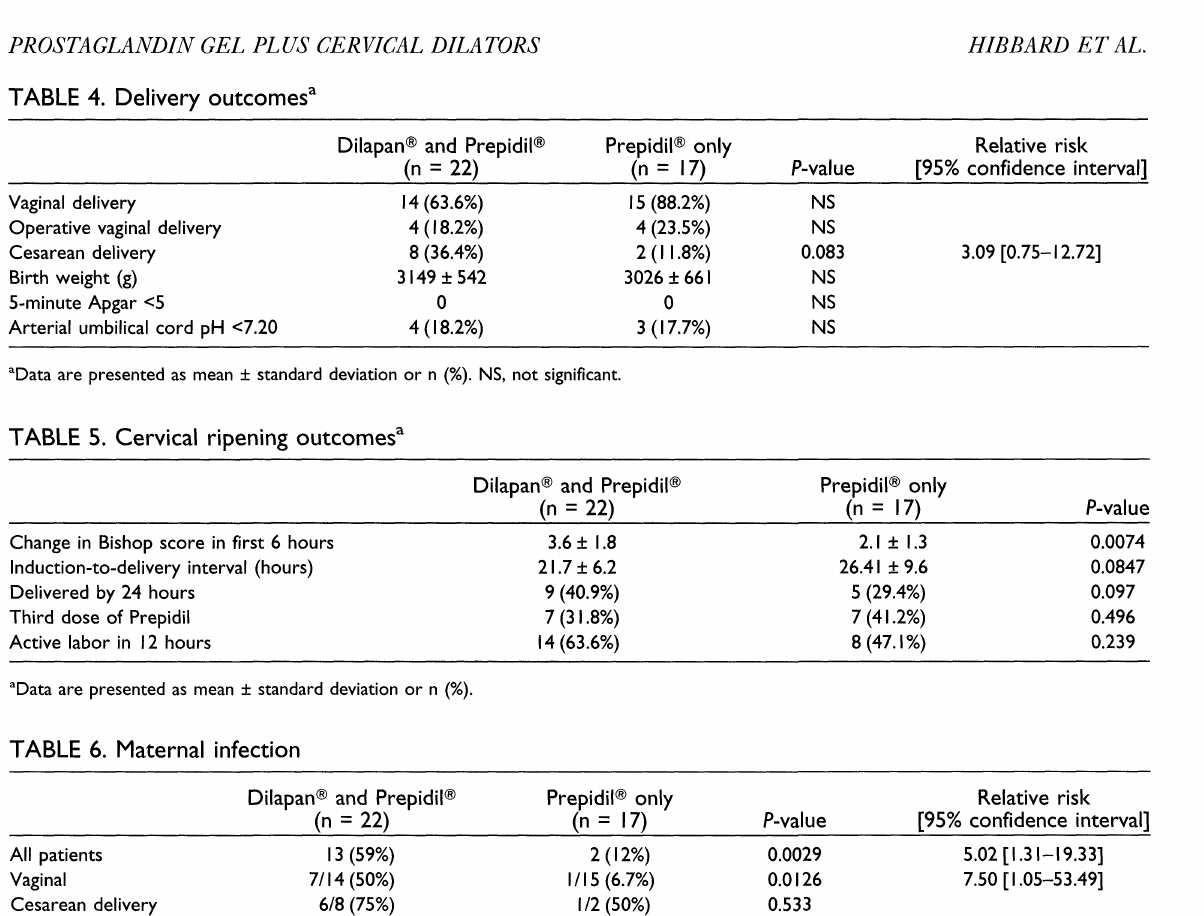
Dilapan (R) and Prepidil (R) (n